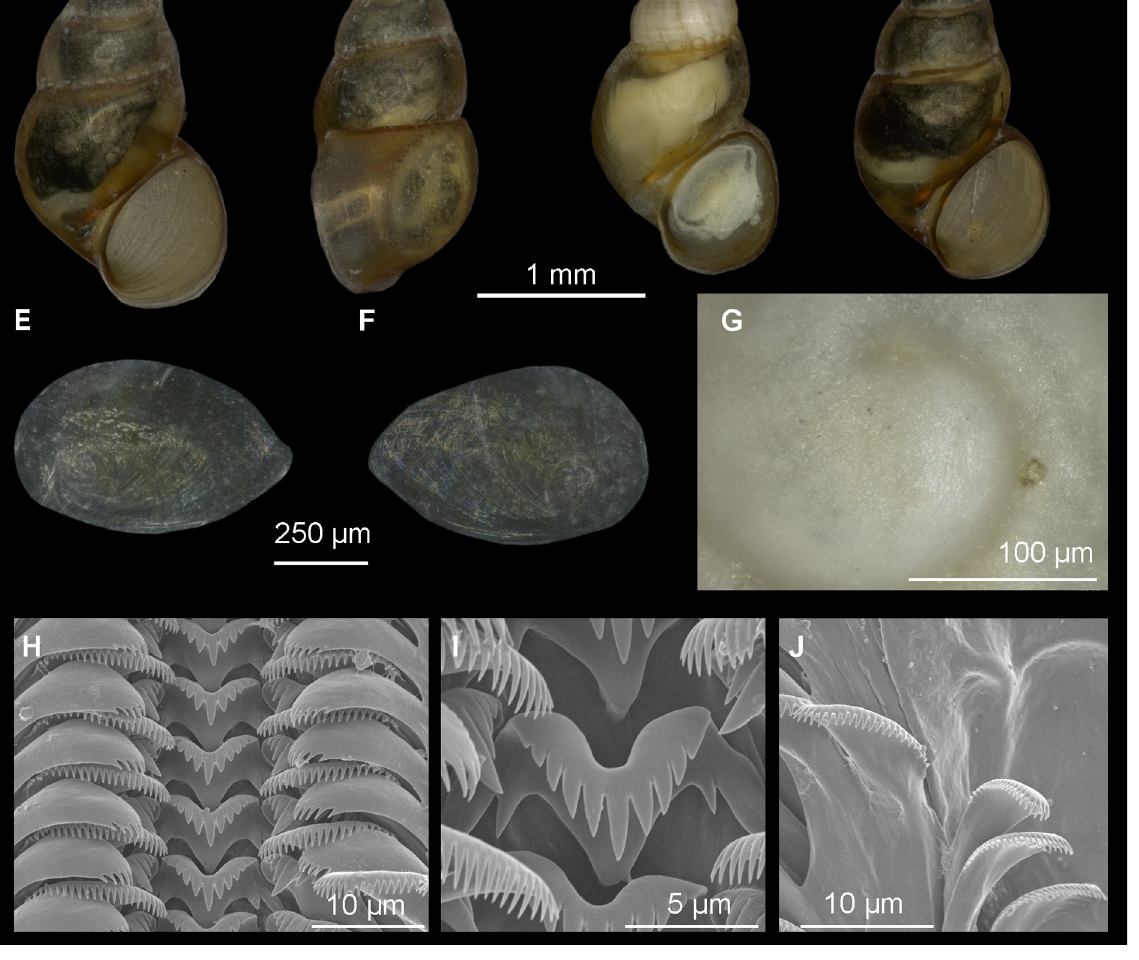
Fig. 7. Shells, opercula and radulae, Biserta putealis gen. et sp. nov. A–D . Shells. A–B .